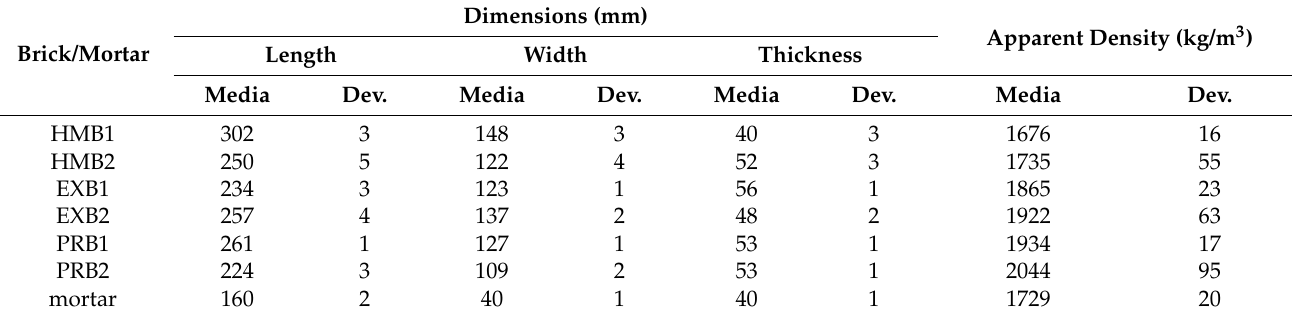
Table 2. Material properties: dimensions, water absorption and apparent